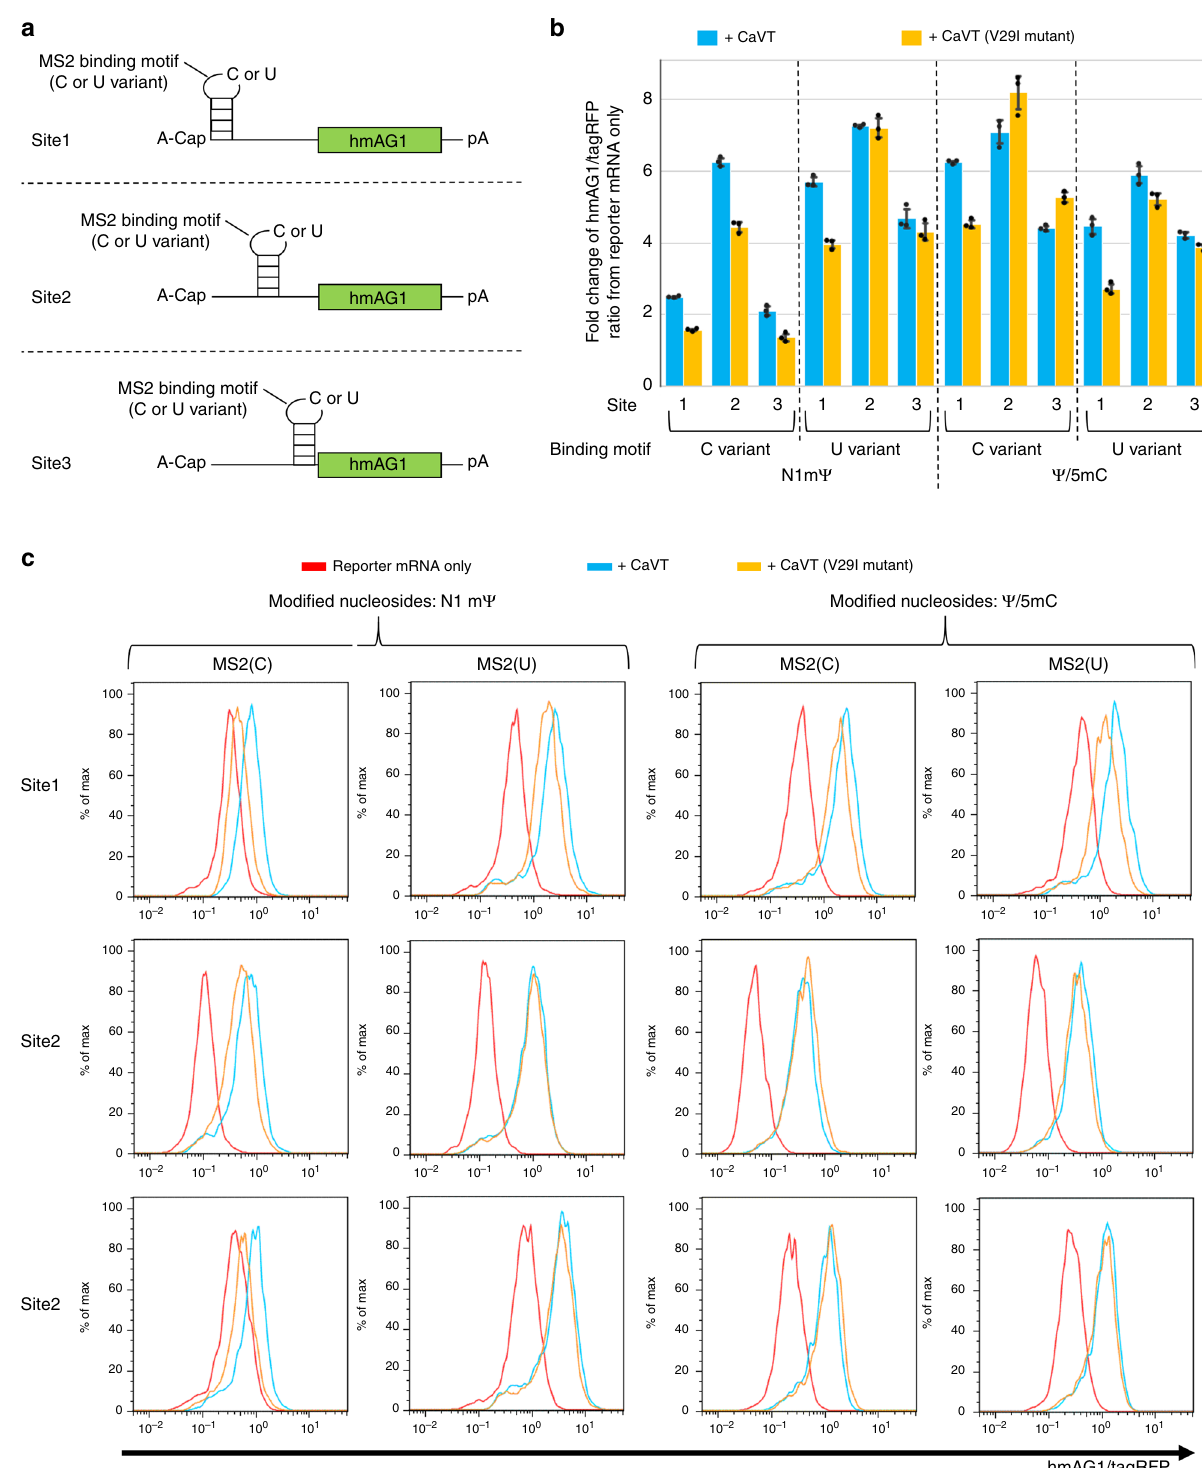
Fig. 3 Effects of modi fi ed nucleosides, sites, and variants of MS2-binding motif and of variants of MS2CP on translational activation by CaVT. HeLa cells were co-transfected with hmAG1 mRNAs with MS2-binding motif (cap analog: A-cap, modi fi ed nucleosides: N1m Ψ or Ψ /5mC), tagRFP mRNA, and an mRNA that expresses CaVT or its V29I mutant. The fl uorescence was measured by a fl ow cytometer. a Schematic diagrams of hmAG1 mRNAs with MS2 binding motif. b CaVT (or its V29I mutant)-mediated fold change of the hmAG1/tagRFP ratio in cells transfected with the indicated reporter mRNAs. Means of the hmAG1/tagRFP ratio in each cell expressing both hmAG1 and tagRFP were calculated and normalized by the hmAG1/tagRFP ratio in reporter mRNA only samples. The bar graph shows the average of three independent experiments (mean ± SD). Source data are provided as a Source Data fi le. c Representative histograms of the hmAG1/tagRFP ratio in cells expressing both hmAG1 and tagRFP. While cells transfected with only reporter mRNAs are shown as red, cells transfected with mRNA that express CaVT or its V29I mutant are shown as cyan and orange,